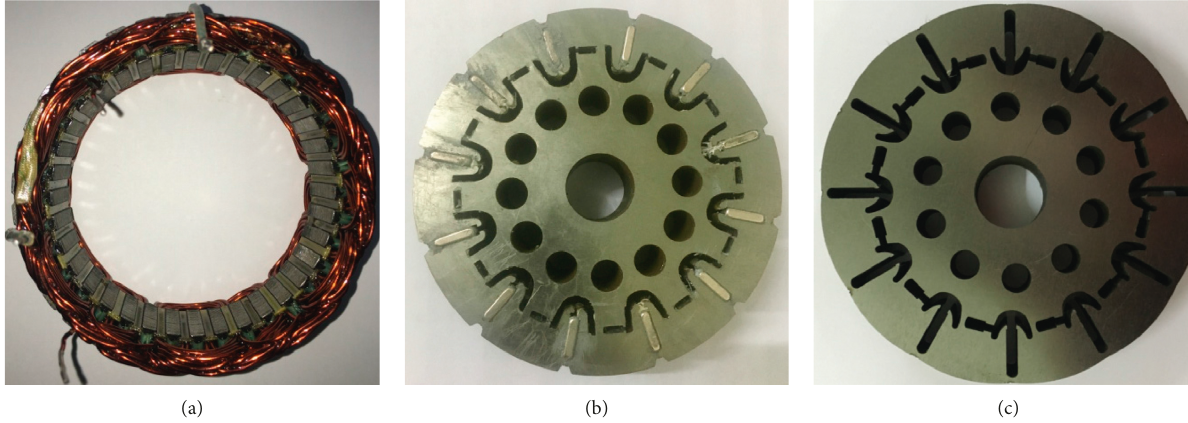
Figure 12: The photographs of ITQPMG. (a) The stator of ITQPMG. (b) The rotor before optimization. (c) Optimized rotor.